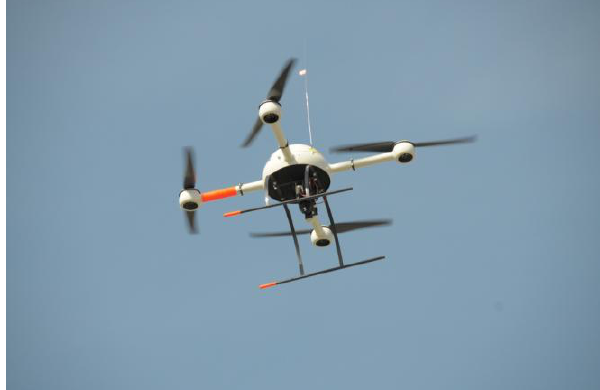
Fig. 1: The microdrones MD4-1000 quadrocopter.